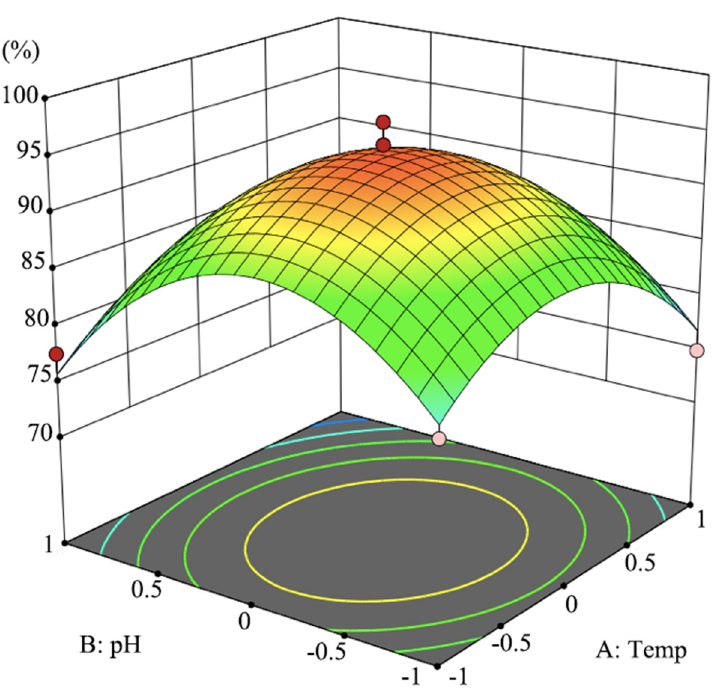
Figure 3. Response surface plot showing the effects of pH and temperature (°C) on D-cyphenothrin degradation by Staphylococcus succinus HLJ-10 while fixing the zero of inoculum size at a coded level.